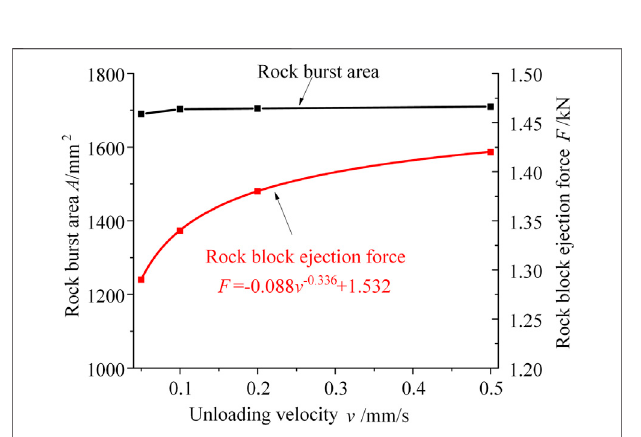
FIGURE 11 | Relationship among the rock burst area, rock block ejection force, and lateral